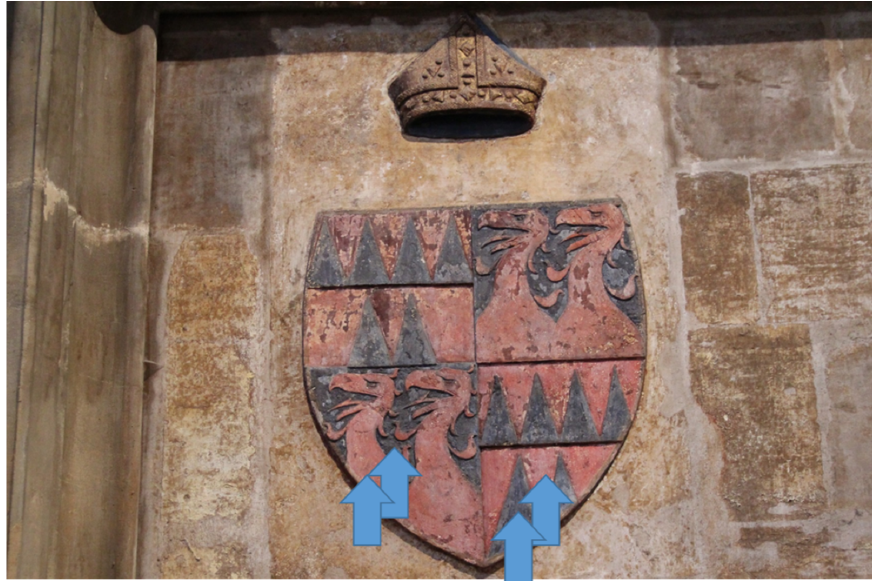
Figure 10. Bishop coat of arms on Vlašim Chapel, arrows indicate measured positions.